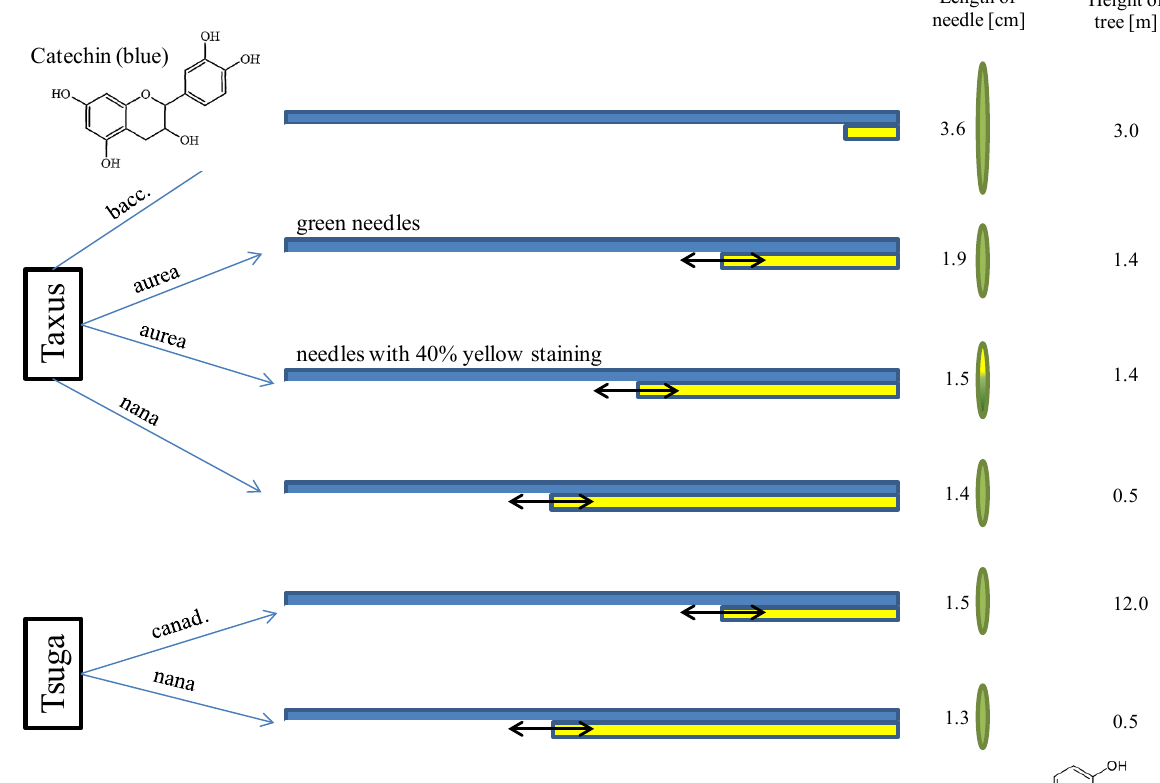
Figure 2. Appearance of yellow flavonols in the blue staining nuclei during the annual growth period of the conifers; as a result, the blue nuclei take on a greenish color; an early change to greenish nuclei is correlated with reduced needle size and tree